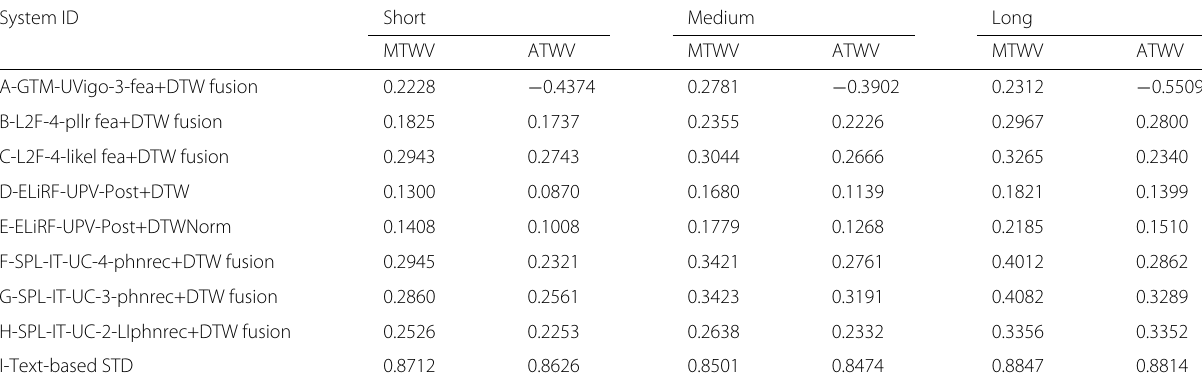
Table 14 System results of the ALBAYZIN QbE STD 2016 evaluation on the EPIC test data based on the query length